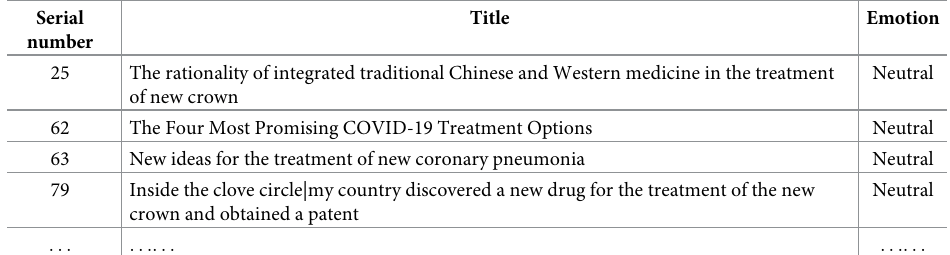
Table 7. Cases of user participation in knowledge sharing of "Lilac Forum" during the